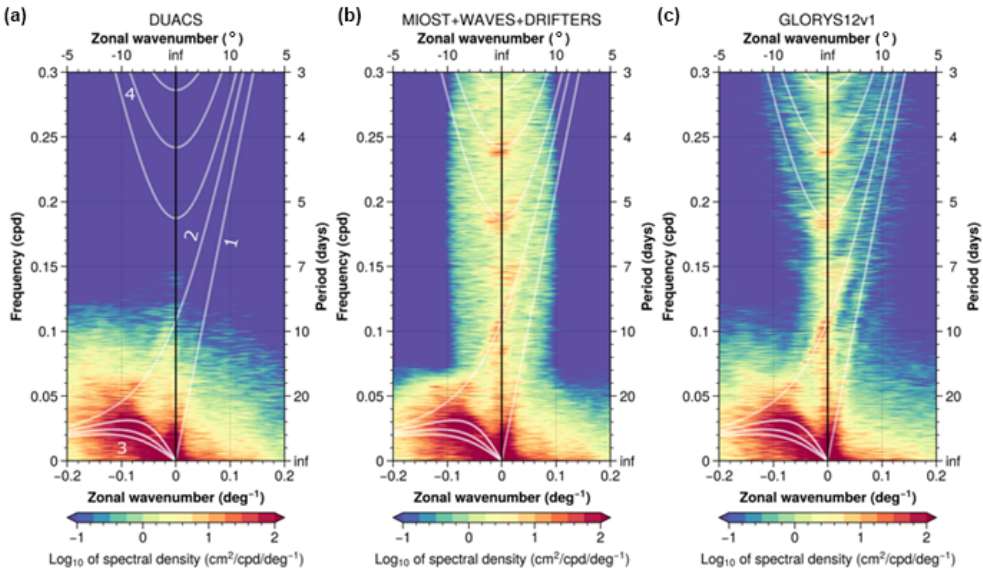
Figure 7. Zonal wavenumber–frequency spectrum of SLA in the equatorial Pacific computed for (a) DUACS, (b) MIOST with equatorial wave modes, and (c) the GLORYS12V1 reanalysis. White lines represent the theoretical dispersion relation curves for equatorial waves corresponding to the Kelvin [1], Yanai [2], Rossby [3], and Poincaré [4]